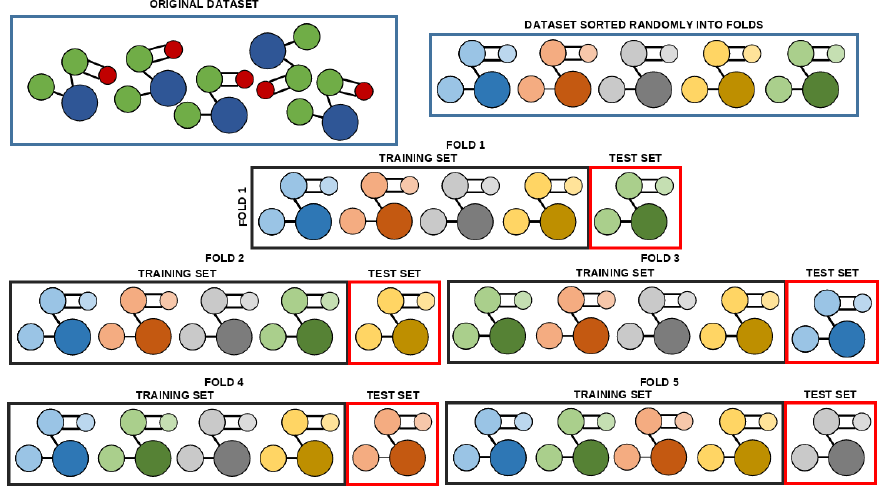
Figure 6. The illustration of the five-fold cross-validation procedure used in the research.